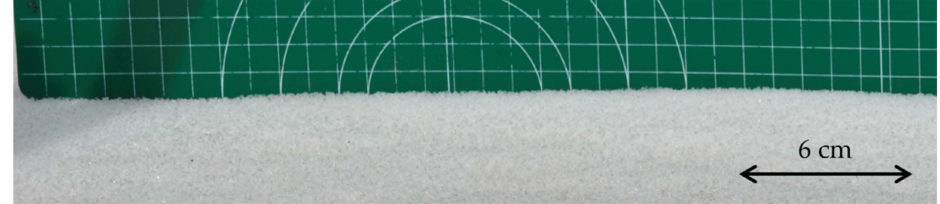
Figure 6. Image of the snow surface